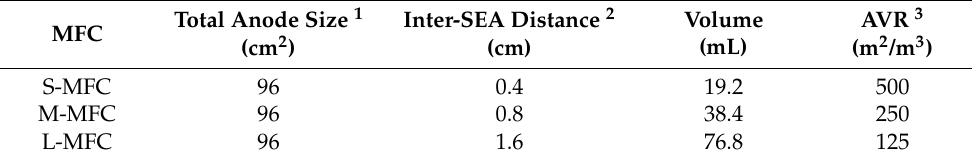
Table 1. Configuration of small (S-), medium (M-), and large (L-) microbial fuel cells (MFCs) used in a stack system.